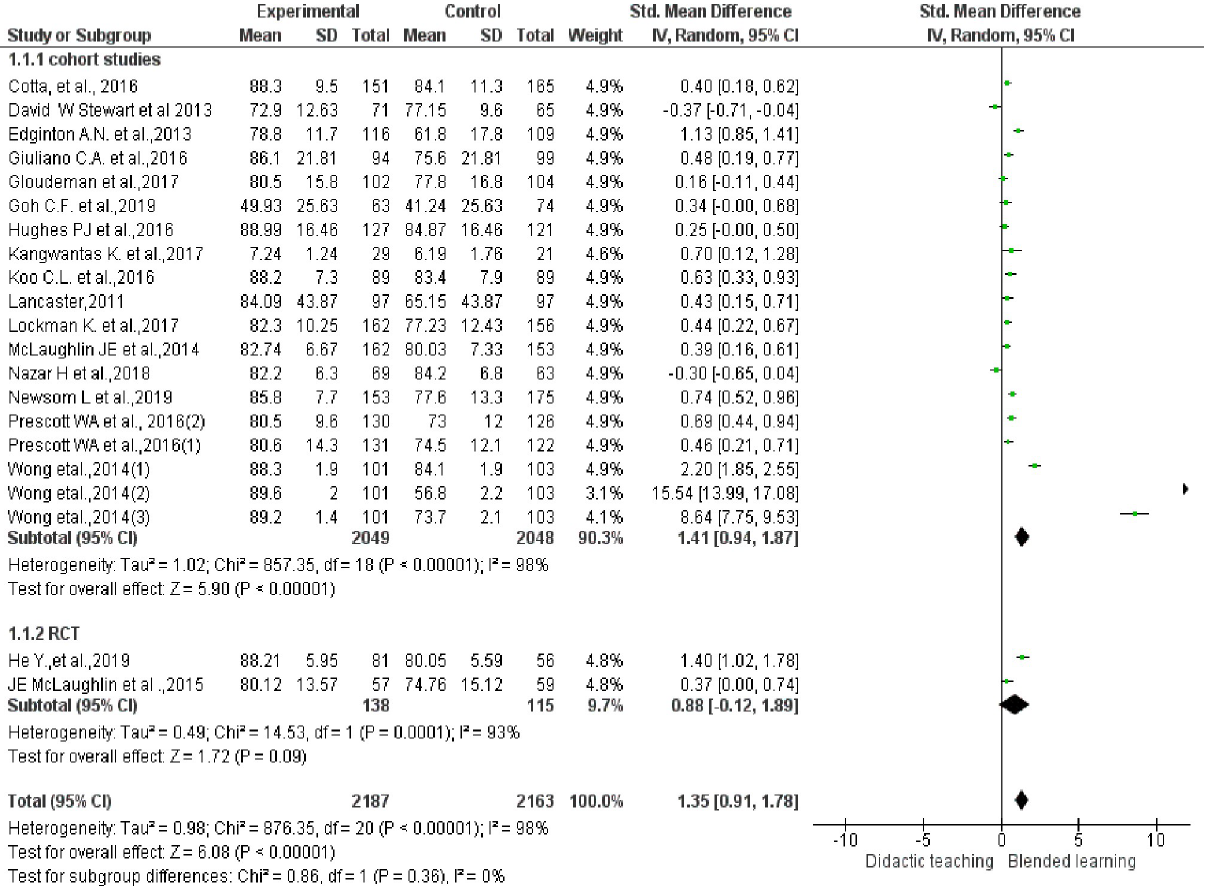
Fig 2. Efficacy of BL vs. traditional teaching in improving knowledge. If more than one topic was delivered by BL in same study (Prescott, Wong) with separate scores for each, we considered them as separate studies (Prescott 1&2, Wong 1, 2&3).